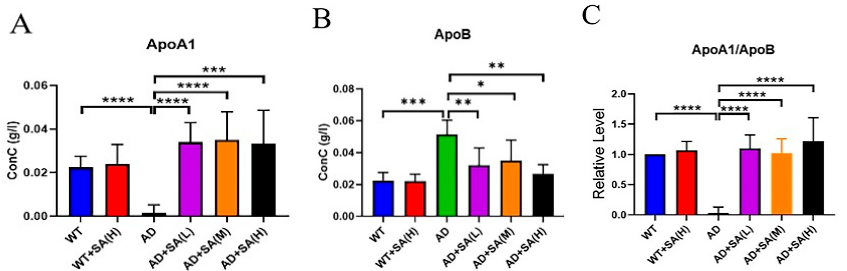
Figure 6. Effect of SA treatment on blood lipid-related indicators in 2×Tg AD mice. ( A ) Apolipopro- tein A1. ( B ) Apolipoprotein B. ( C ) Apolipoprotein A1 is better than apolipoprotein B (* p < 0.05, ** p < 0.01, *** p < 0.001, and **** p < 0.0001). Student’s t test was used for statistical analysis. Error bars represent the mean ± SEM ( n = 6).